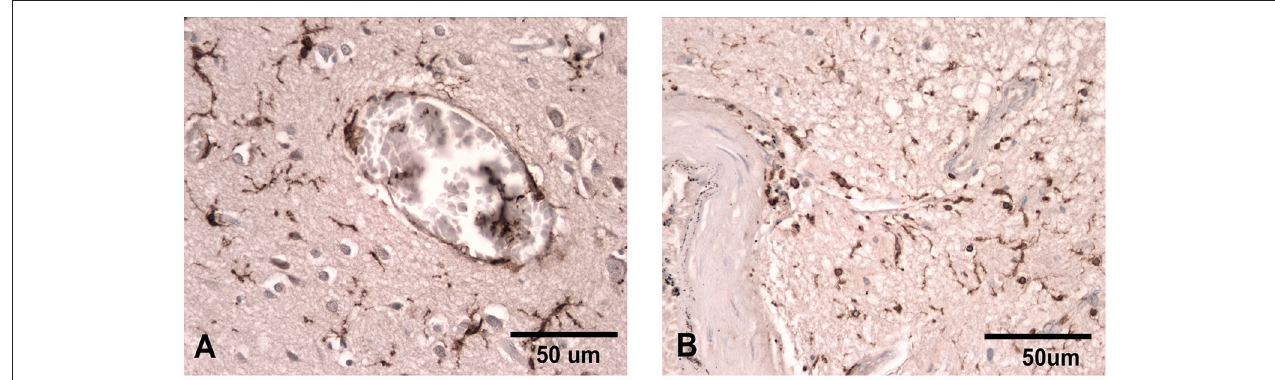
FIGURE 1 | Iba-1 staining illustrating the ramified microglial morphology associated with normal surveillance activity (A) compared to that seen in patients where there has been damage to the vasculature and the microglia take on a more rounded phagocytic appearance (B) . Scale bar corresponds to 50 µ